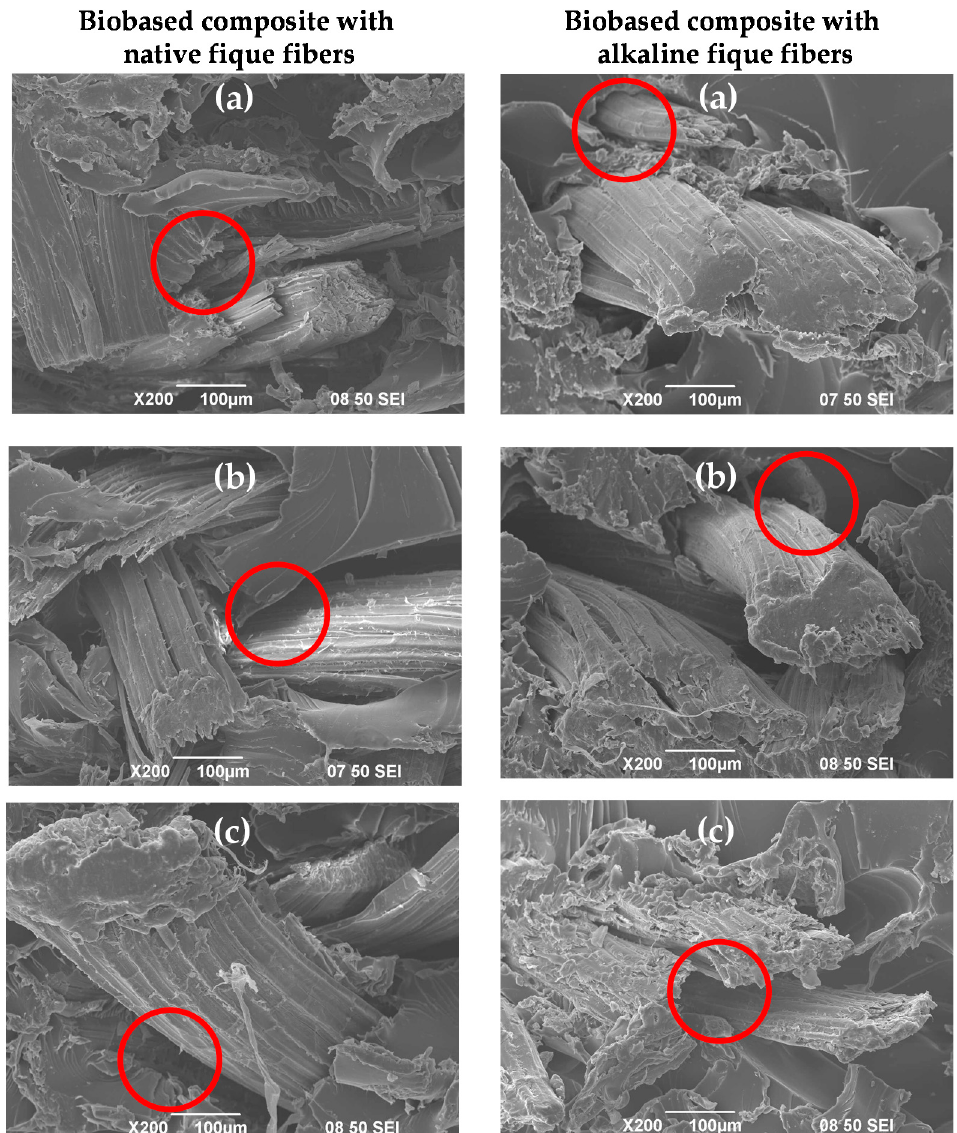
Figure 7. Scanning Electron Images of fracture surfaces of the biobased composite with native and alkaline fibers conditioned at ( a ) a relative humidity of 47%; ( b ) a relative humidity of 77%; ( c ) a relative humidity of 97%. The red circles show voids between the fiber and the matrix.